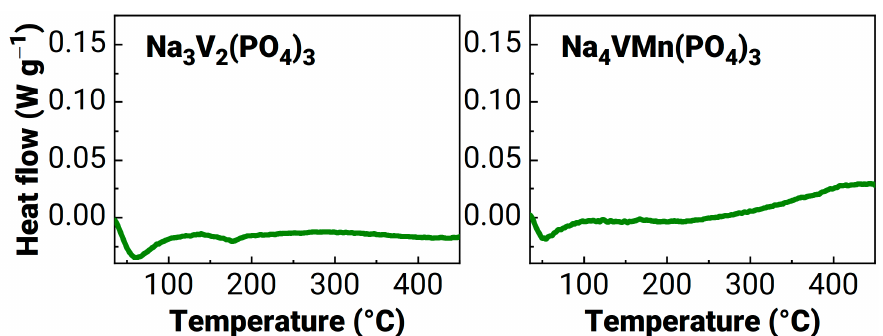
Figure 3. DSC curves for the pristine powders of Na 3 V 2 (PO 4 ) 3 and Na 4 VMn(PO 4 ) 3 cathode materials. The DSC curves of the charged, washed and dried electrodes are presented in Figure